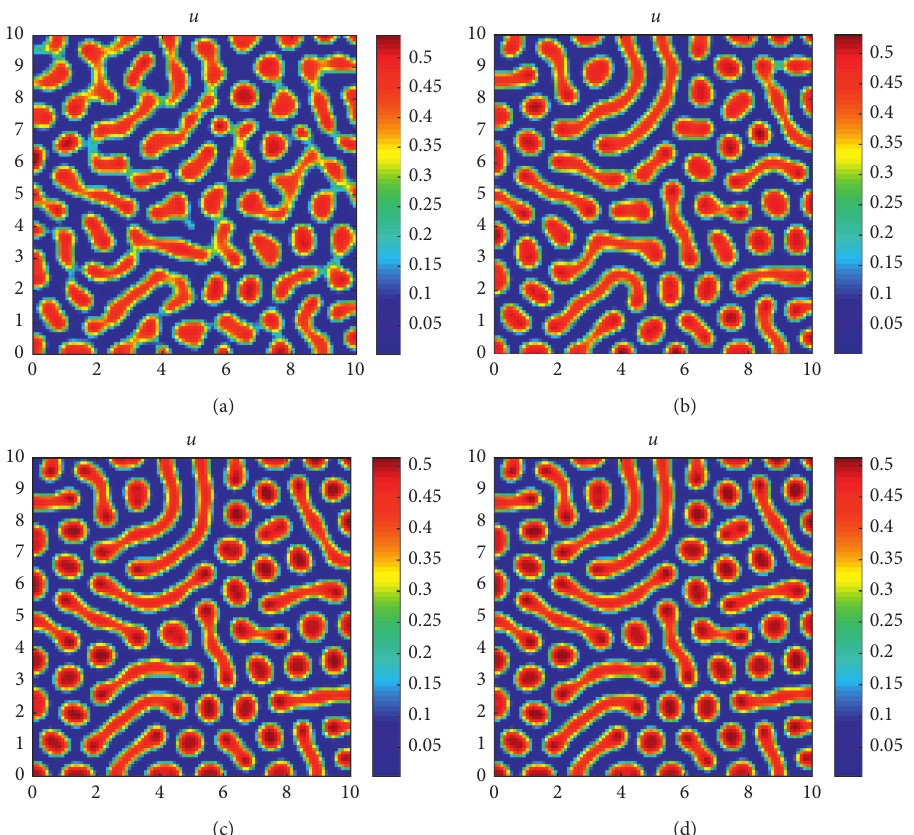
Figure 1: Mixture patterns obtained with model [1] for A � 0 and τ � 0. Time: (a) t � 100, (b) t � 500, (c) t � 2000, and (d) t � 5000.